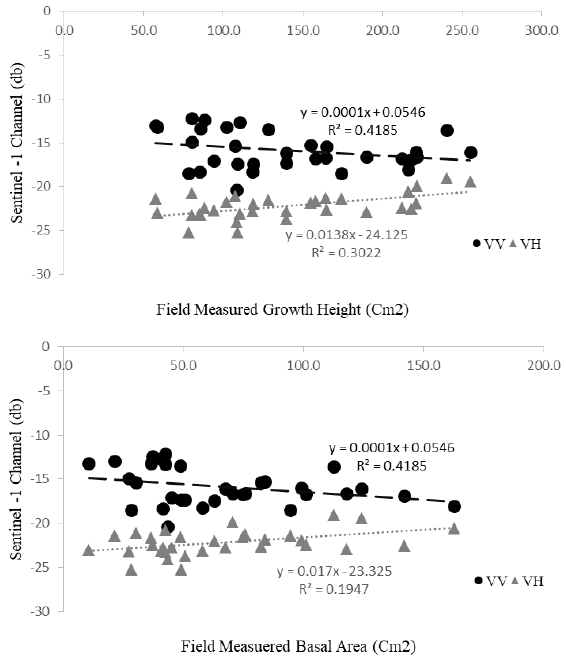
Figure 6. Relationships of basal area, growing height and Sentinel-1 SAR backscatter coefficient (σo, dB) in each plot. using remote sensing data Compared to linear regression, the use of remote sensing method gave better biomass prediction from Sentinel-1 SAR and Sentinel-2-derived band combination and vegetation index, respectively. However, for Pleiades-1 and Sentinel-2 derived vegetation cover data (supervised classified vegetation cover area from Blues, Green, Red and NIR bands), linear regression gave better biomass prediction than band combination and vegetation index.